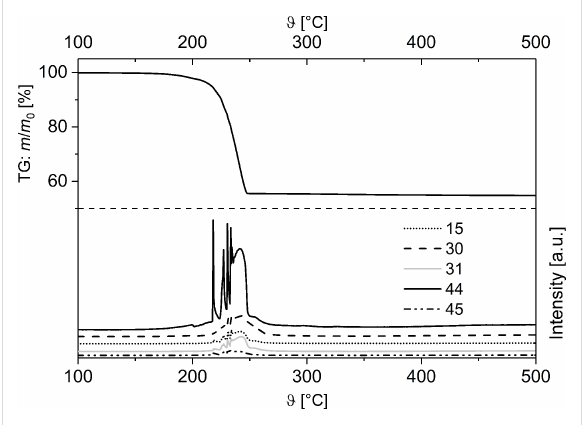
Figure 3: TG trace (Ar, gas flow 60 mL min − 1 , heating rate 10 °C min − 1 ) and selected mass-spectrometric scans (bottom) of 1 : m / z = 45 (C 2 H 5 O + ), 44 (CO 2+ ), 31 (CH 3 O + ), 30 (CH 2 O + ), and 15 (CH 3+